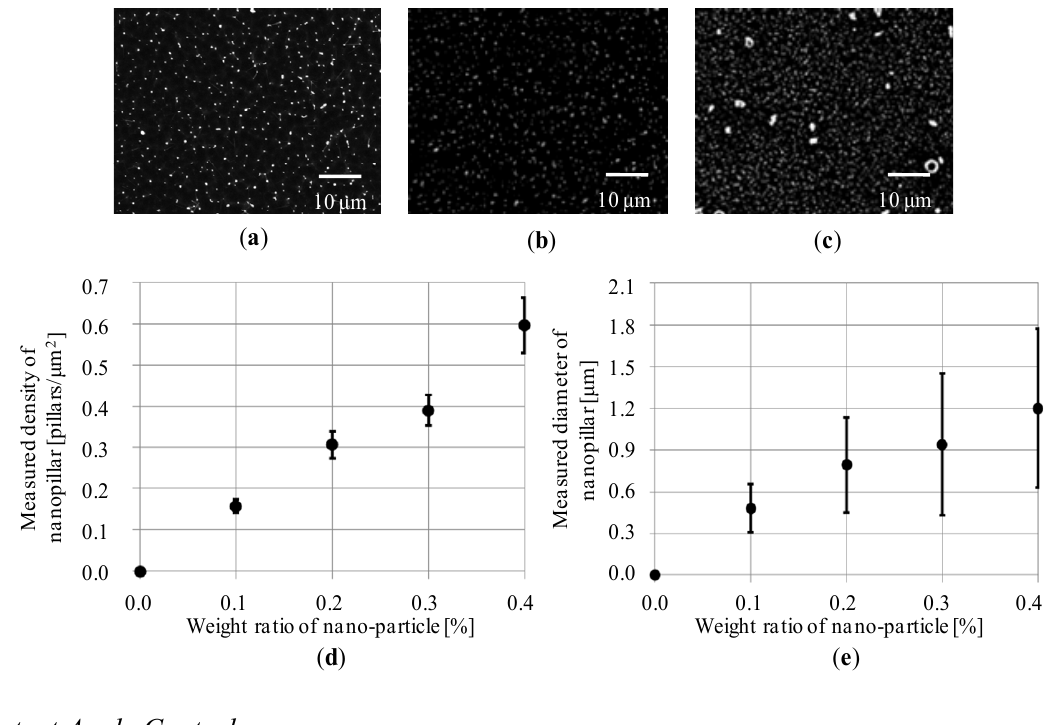
Figure 4. SEM images of the top of the nanopillar and measured density of the nanopillar as a function of the weight ratio of the nanoparticle. ( a ) 0.10%; ( b ) 0.20 %; ( c ) 0.40%; ( d ) measured density of the nanopillar of the fabricated chip; and ( e ) measured diameter of the nanopillar of the fabricated